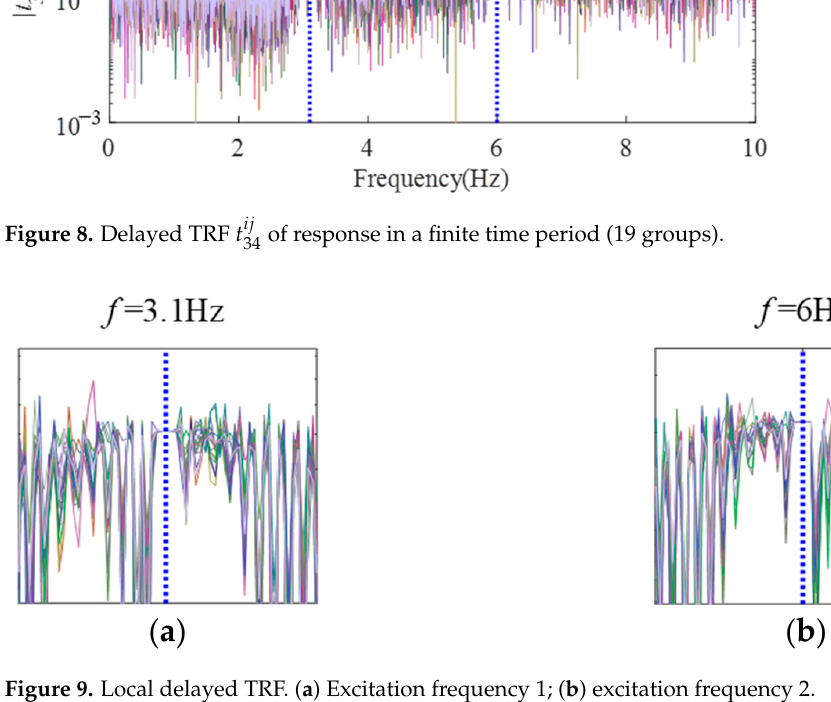
At the same time, the quasi-frequency response function was constructed according to